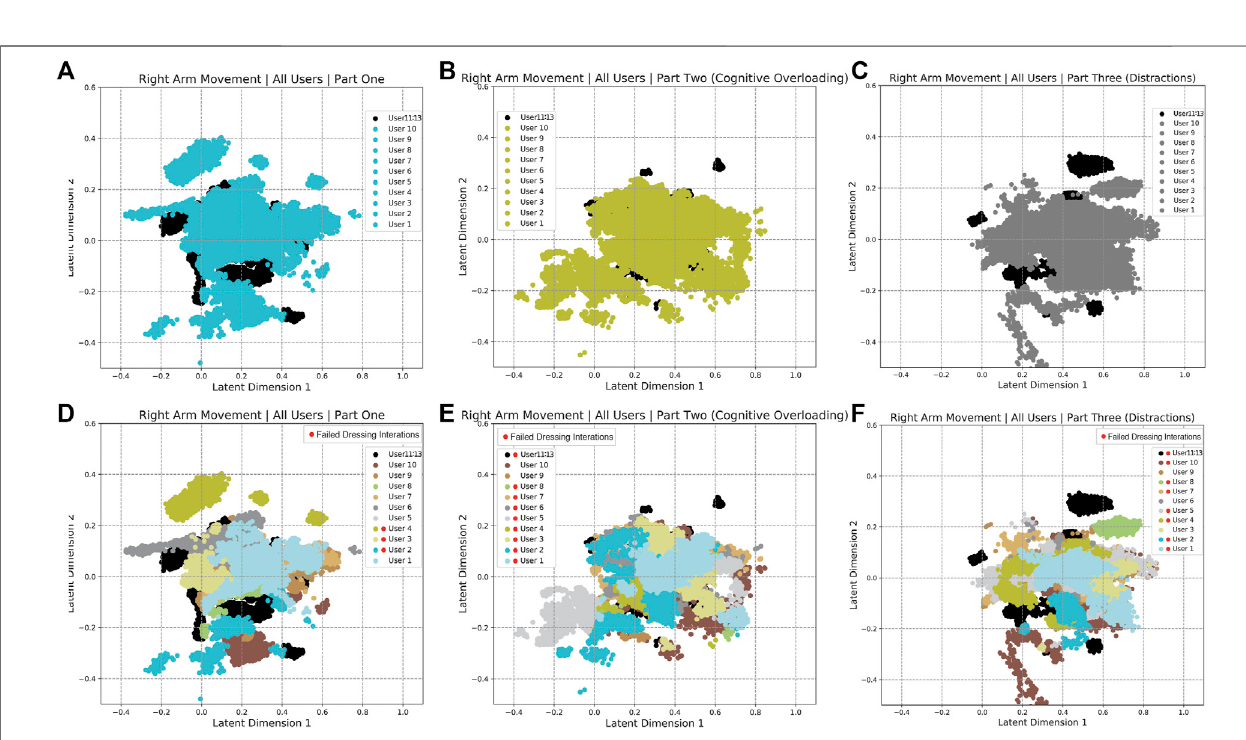
FIGURE10| SeparatedLatentSpacerepresentationoftherightarmmovementsforPartOne (A,D) ,PartTwo (B,E) andPartThree (C,F) . (Panels A – C) showthe 2-Dlatentspacerepresentationforalltheparticipants. (PanelsD – F) showstherepresentationoftenindividualparticipants.Theparticipantsmarkedwithareddotinthe legend had dressing failures in their dressing